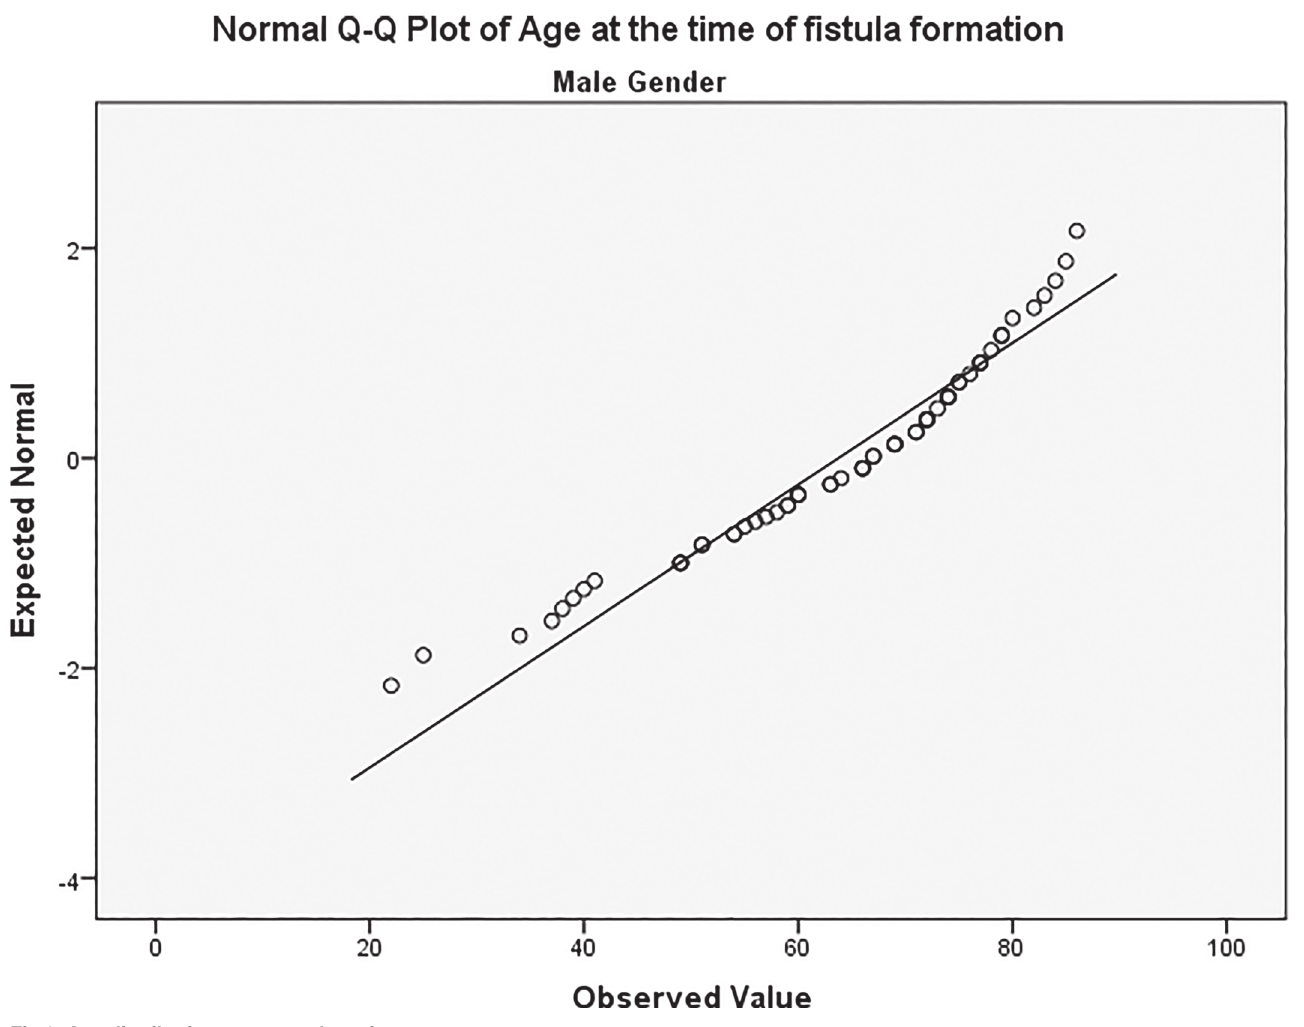
Fig 1. Age distribution among male